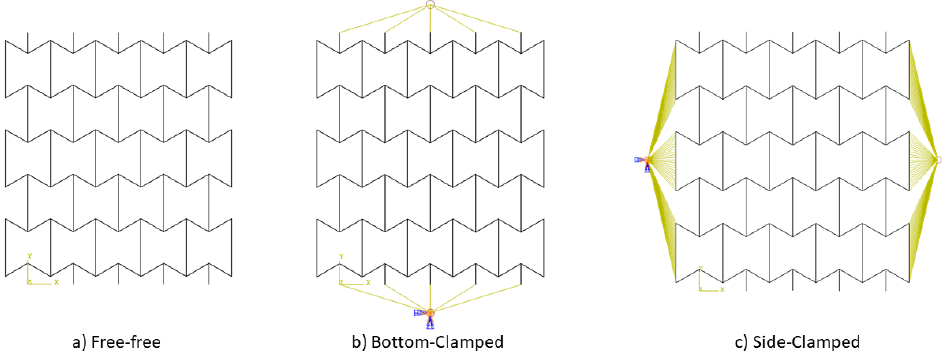
Figure 4. Boundary conditions shown on the re-entrant lattice structure configuration: Bottom- Clamped ( b ) and Side-Clamped ( c ).